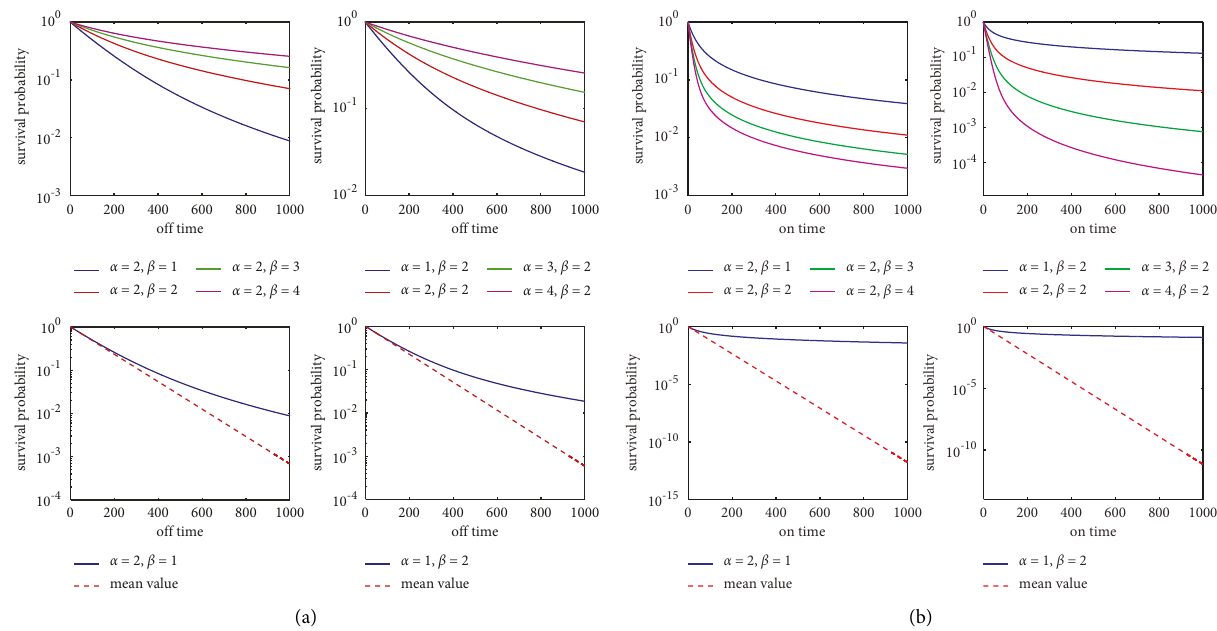
Figure 3: The extracellular fluctuations make the dwell time drift with a repressor, and the first row represents the upstream input as noise, whereas the second row represents the difference in the dwell time between the noise and noiseless signal. (a) The OFF-state dwell time under the FM paradigm with the extracellular stimulus increasing its burst frequency or burst size; (b) the ON-state dwell time under the AM paradigm when the extracellular stimulus strength increases. The means of the coloured lines are similar to (a). The other parameters are the same as in Figure